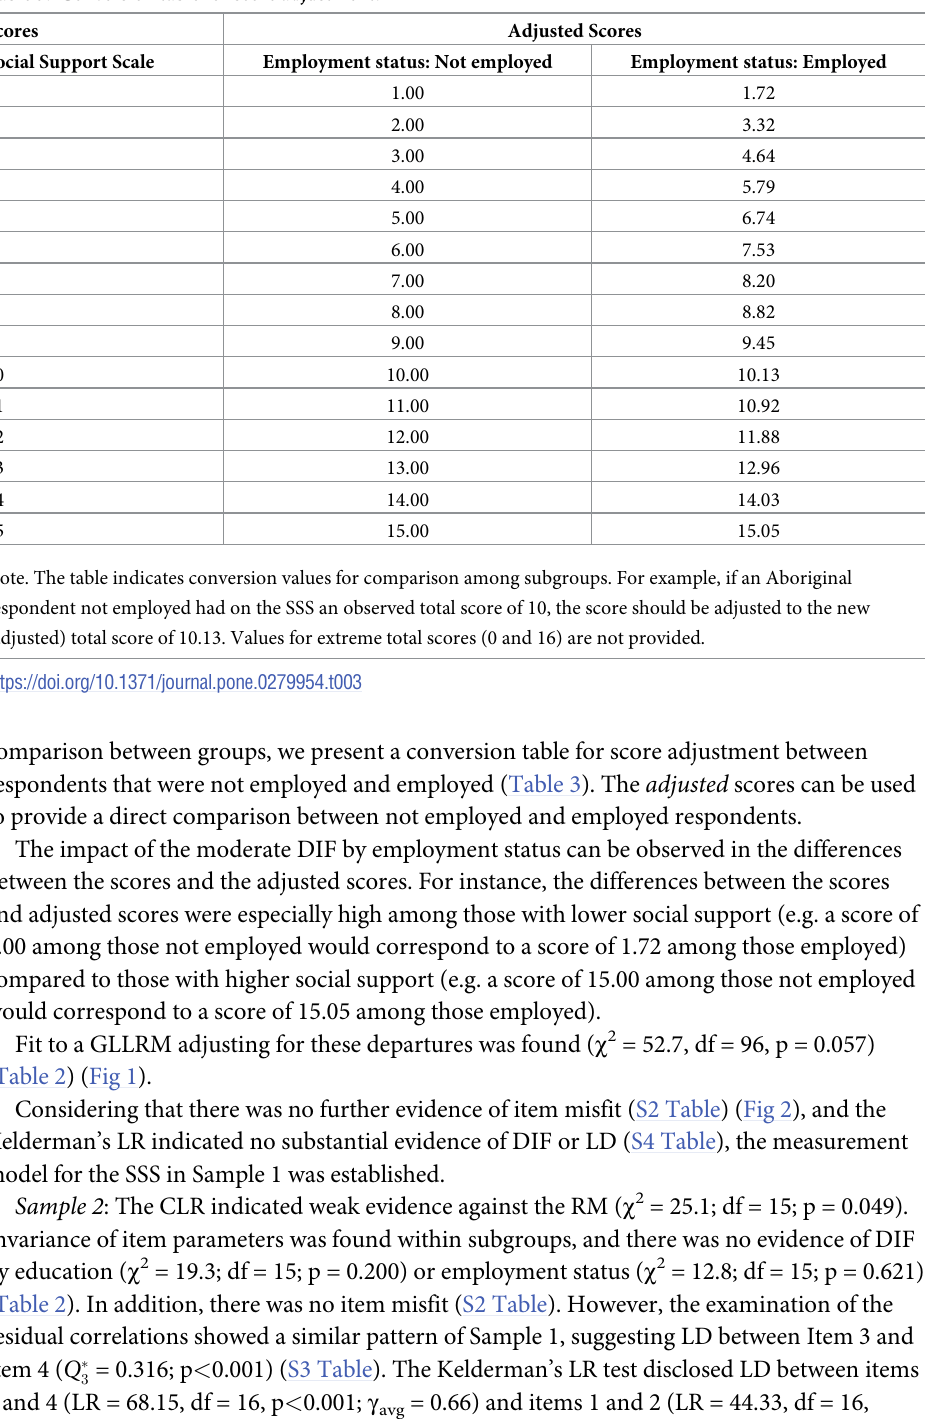
Table 3. Conversion table for score adjustment.